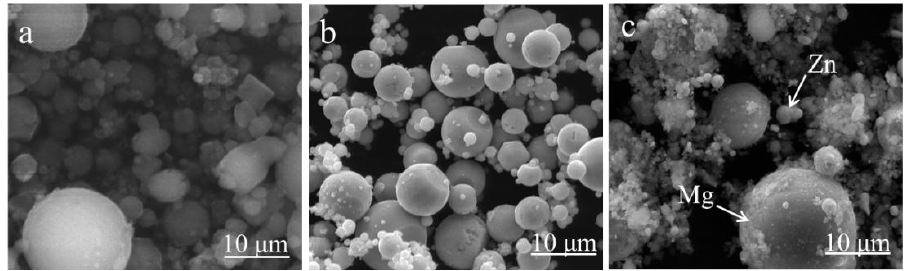
Figure 1 . The original powder: ( a ) Mg; ( b ) Zn; and ( c ) mixed powder. Figure 1. The original powder: ( a ) Mg; ( b ) Zn; and ( c ) mixed